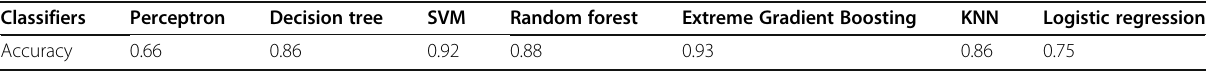
Table 1 Classifier accuracy on student dataset Classifiers